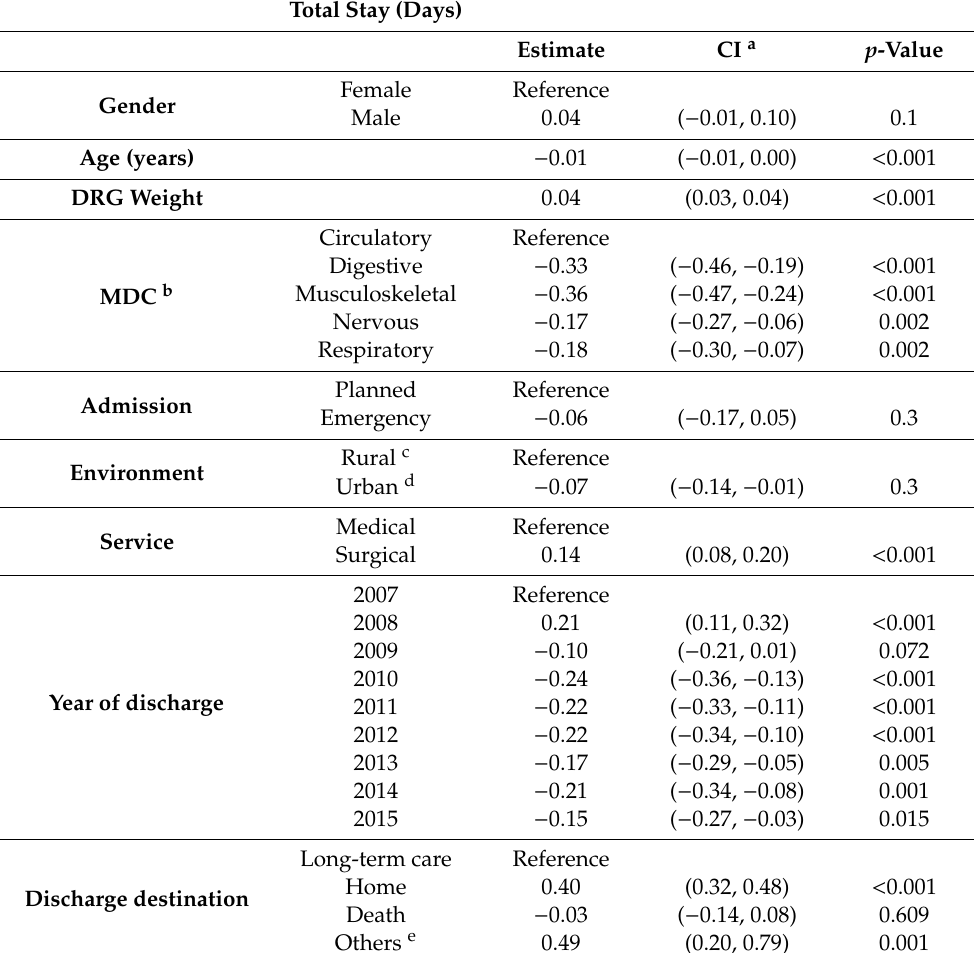
Table 2. Univariate analyses. Cantabria (Northern Spain),